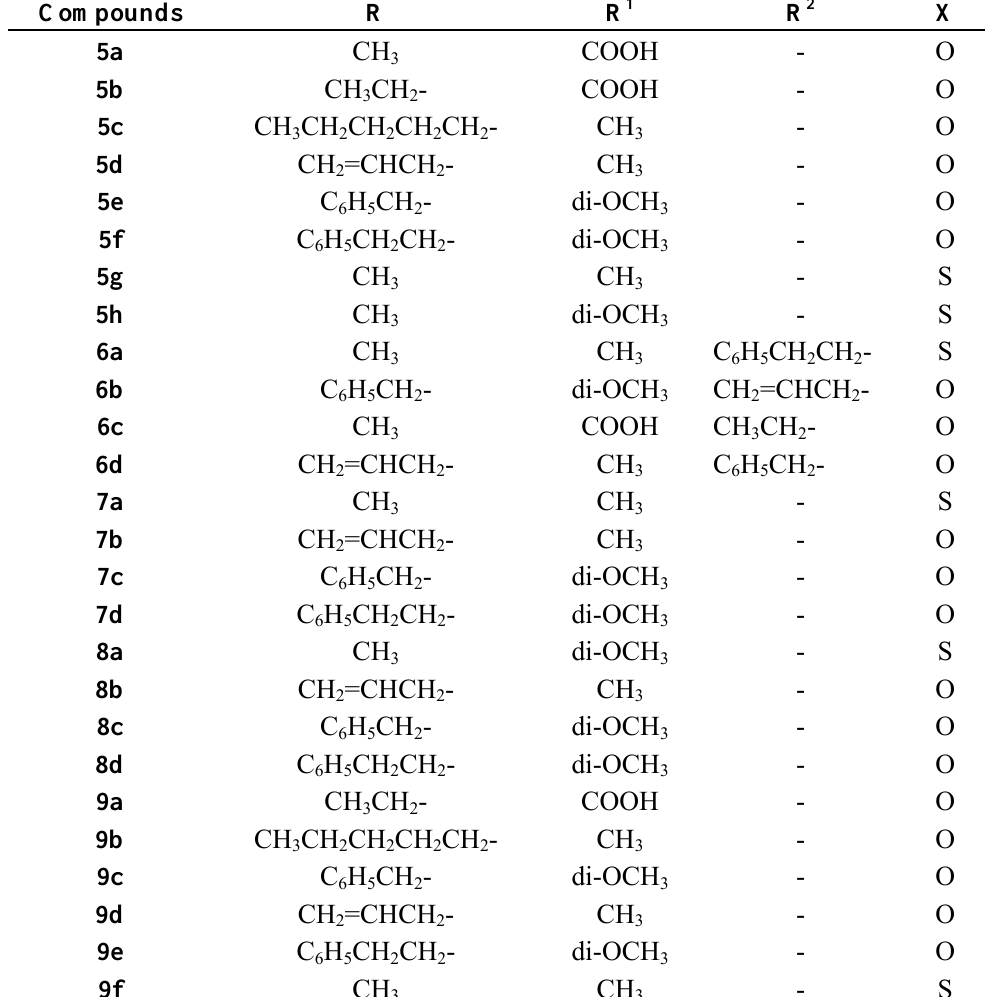
Table 1. Prepared compounds 5-9